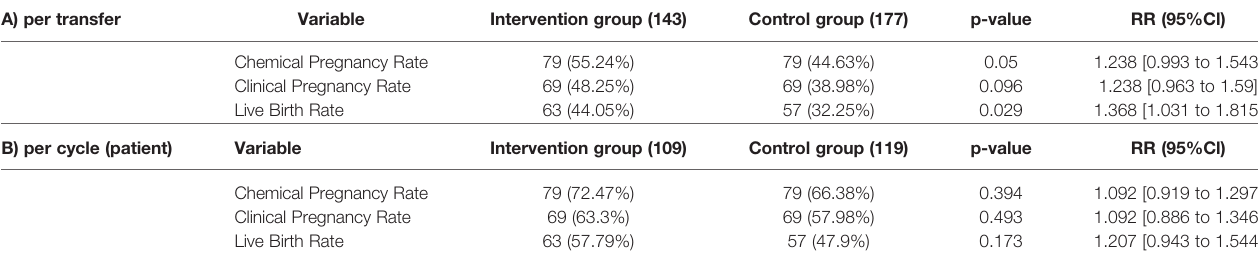
TABLE 6 | Cumulative Pregnancy